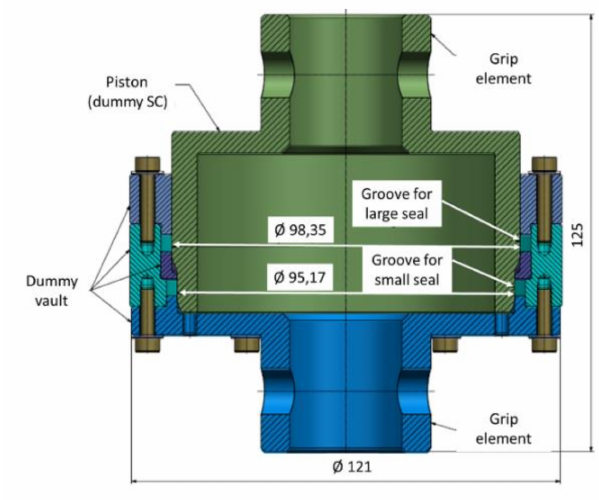
Figure 9. Cross-section through the testing device.